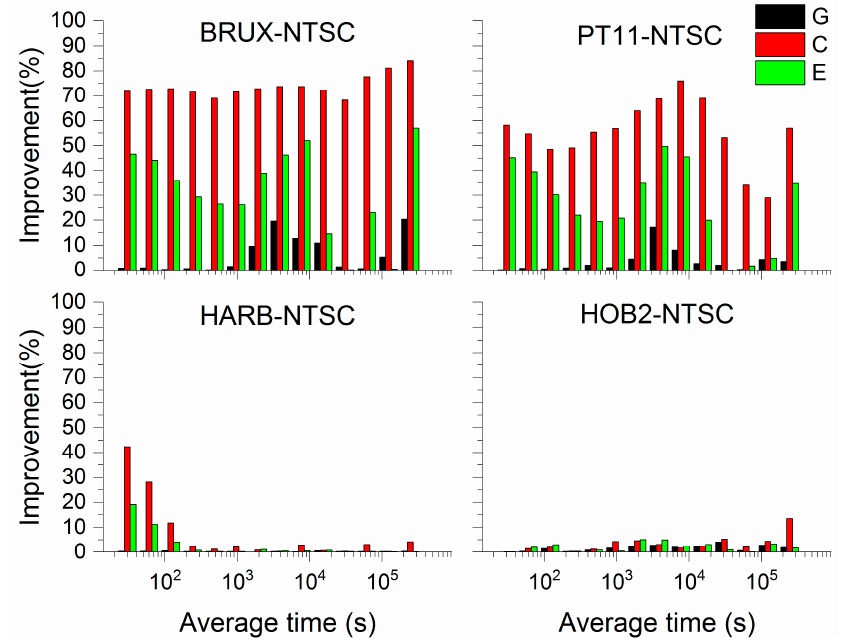
Figure 9. Percentage improvement in the stability of multi-GNSS over the single-system using COD products.